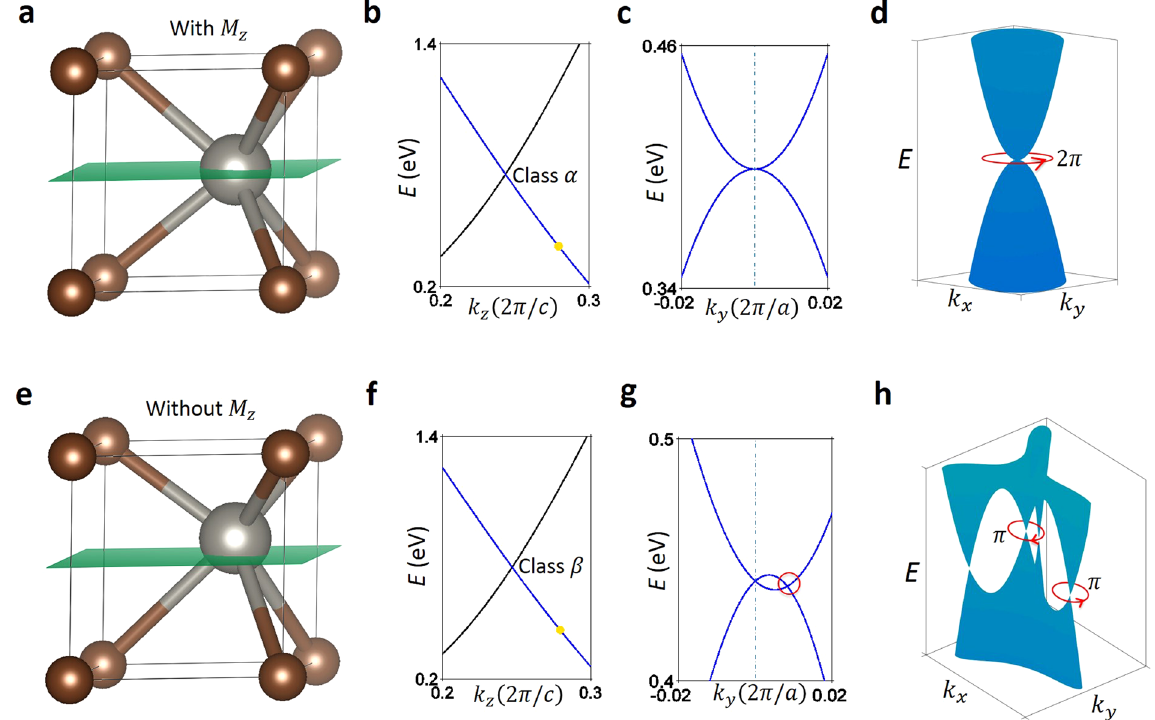
Figure 6. Transition from Class α to Class β by breaking  mirror symmetry. ( a ) Crystal structure of WC z with the W and C atoms represented by silver and bronze spheres and the k z = 0 (  ) mirror plane by a green z plane. ( b ) Band structure along k z and around the triply degenerate band crossing for Class α . The blue and black bands denote the doubly and singly degenerate bands, respectively. ( c ) At the location marked by the yellow dot in ( b ), we present the band dispersion of the doubly degenerate band along the in-plane k y -direction. A quadratic dispersion for the ψ ′ and ψ ′ bands and a touching point between them is observed. The two bands 1 2 are colored blue to signify they are from the doubly-degenerate band in ( b ). ( d ) A trivial Berry phase of 2 π was computed for a closed loop around the touching point in ( c ). ( e ) The displacement of the W atom in ( a ) along  mirror symmetry. ( f ) Similar to ( b ), but for the broken  the c lattice constant direction breaks the mirror z z symmetry case. ( f ) Along a generic k y direction, the doubly degenerate band is shown to have transitioned from mirror symmetry. Specifically, the observed linearly Class α to Class β occurs though breaking the  z and ψ ′ signifies the expected character of Class β . The red circle denotes dispersing touching points between ψ ′ 1 2 one of the two linear touching points. ( h ) Illustration showcasing a non-trivial π Berry phase for a closed loop around the linearly dispersing touching